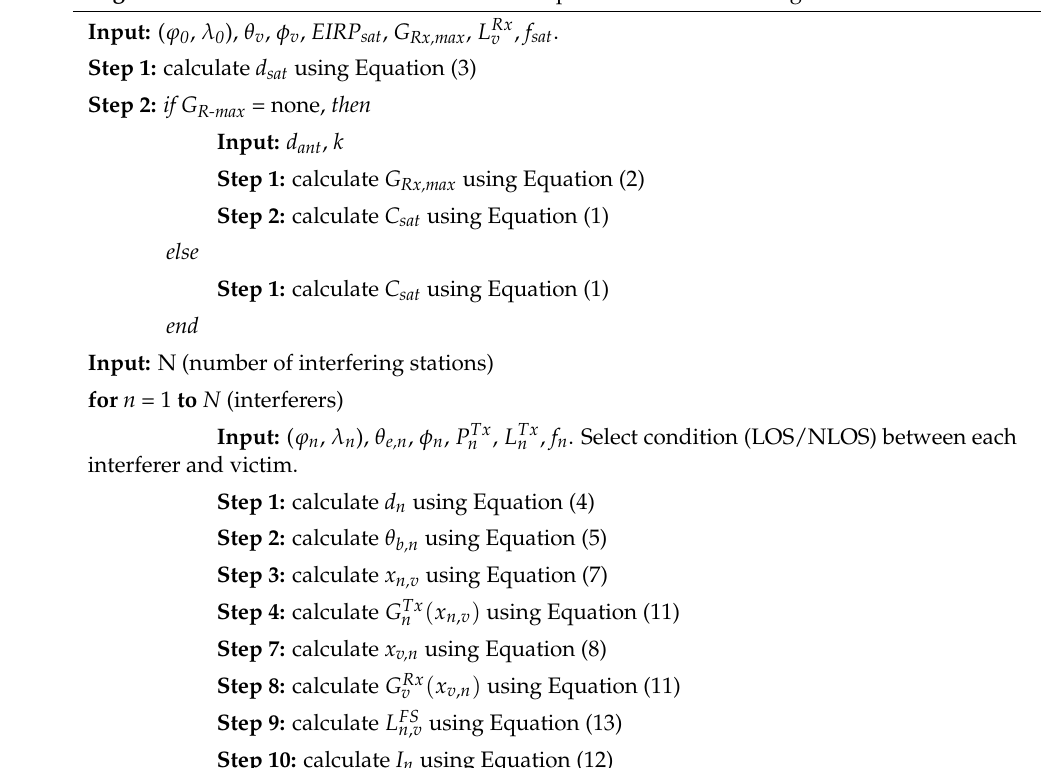
Algorithm 1. Calculation of CIR between multiple interferers and a single